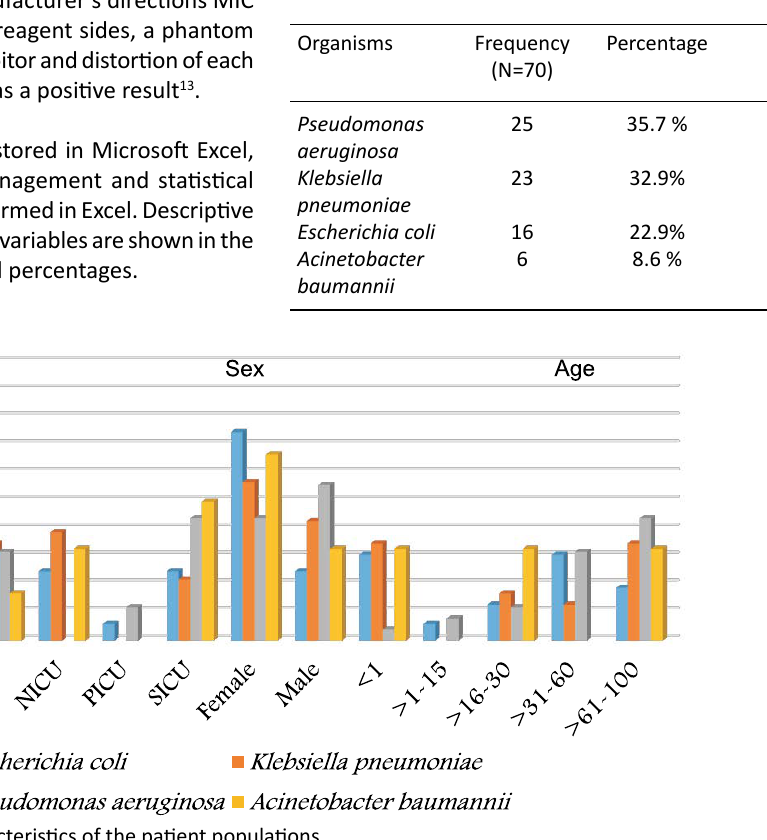
Table 1. Frequencies and percentages of various Gram-